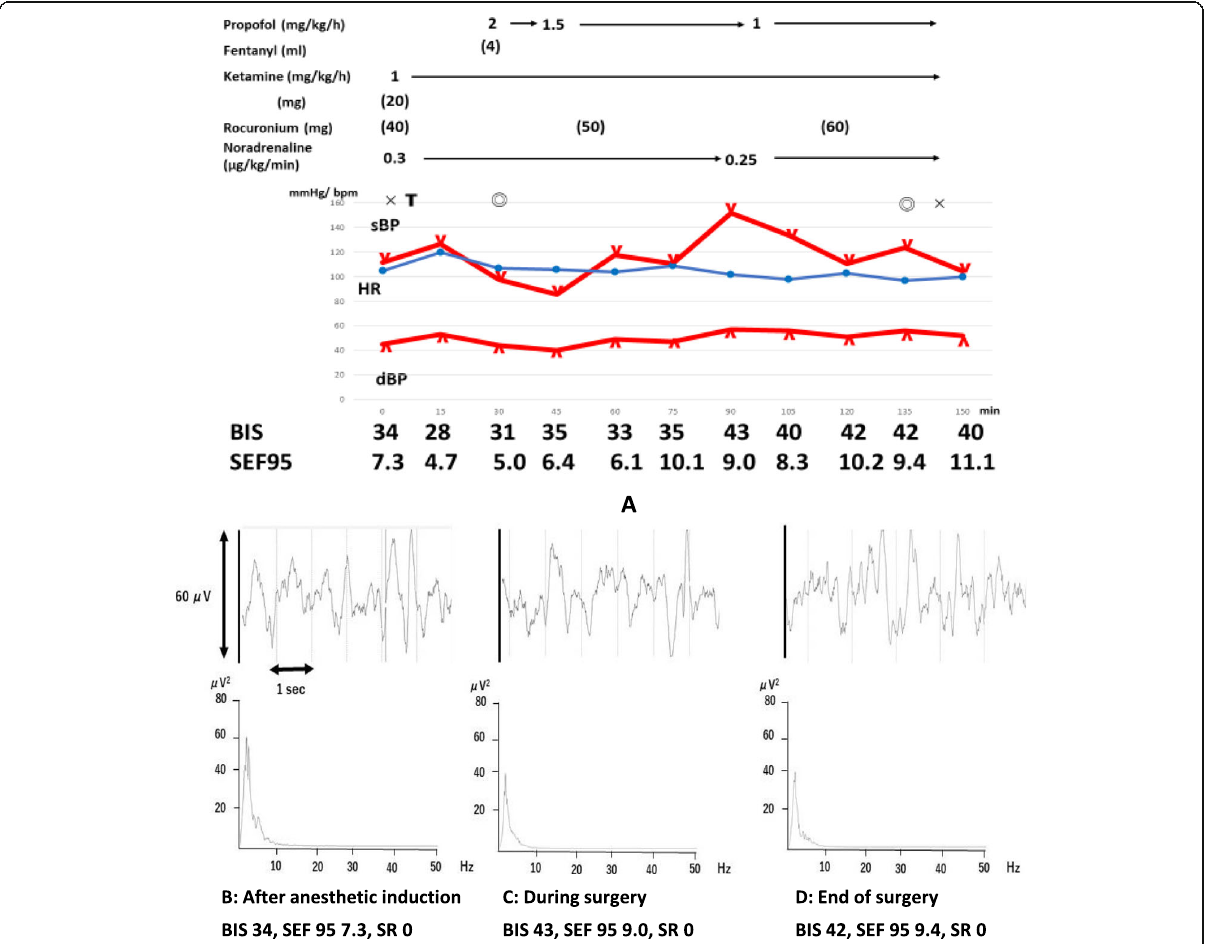
Fig. 2 Anesthesia record. EEG waves and frequency analysis at each point. Anesthetic record is shown in ( a ). The BIS value remained from 30 to 40 throughout the perioperative period. Anesthesia was induced by intravenously injecting ketamine (20mg) and rocuronium bromide (40mg) at that period. The EEG at lower frequency below 8Hz was dominant ( b ). The EEG pattern was continuous throughout the surgery ( c , d ). Abbreviations: HR, heart rate; sBP, systolic blood pressure; dBP, diastolic blood pressure; BIS, bispectral index; SEF95 (Hz), 95% spectral edge frequency; SR (%), suppression